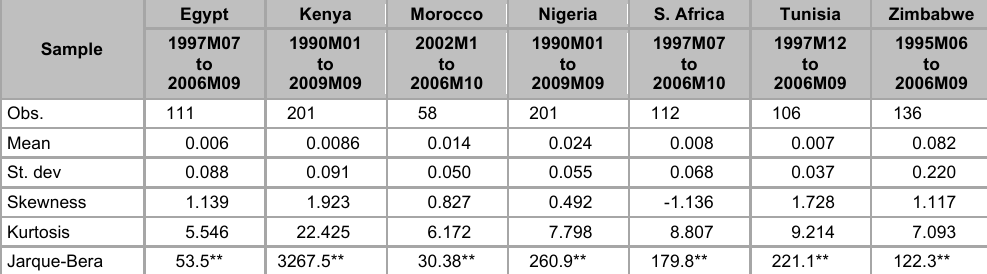
Summary statistics of monthly returns (logarithmic